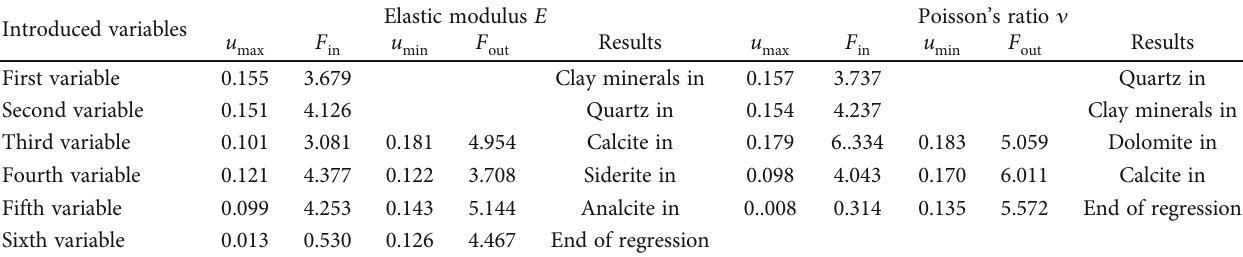
Table 3: Flow table for introducing the elastic modulus and Poisson ’ s ratio